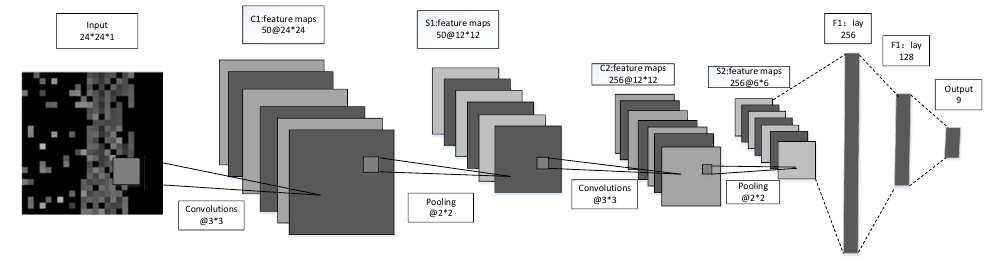
Figure 5. Convolutional neural network (CNN)